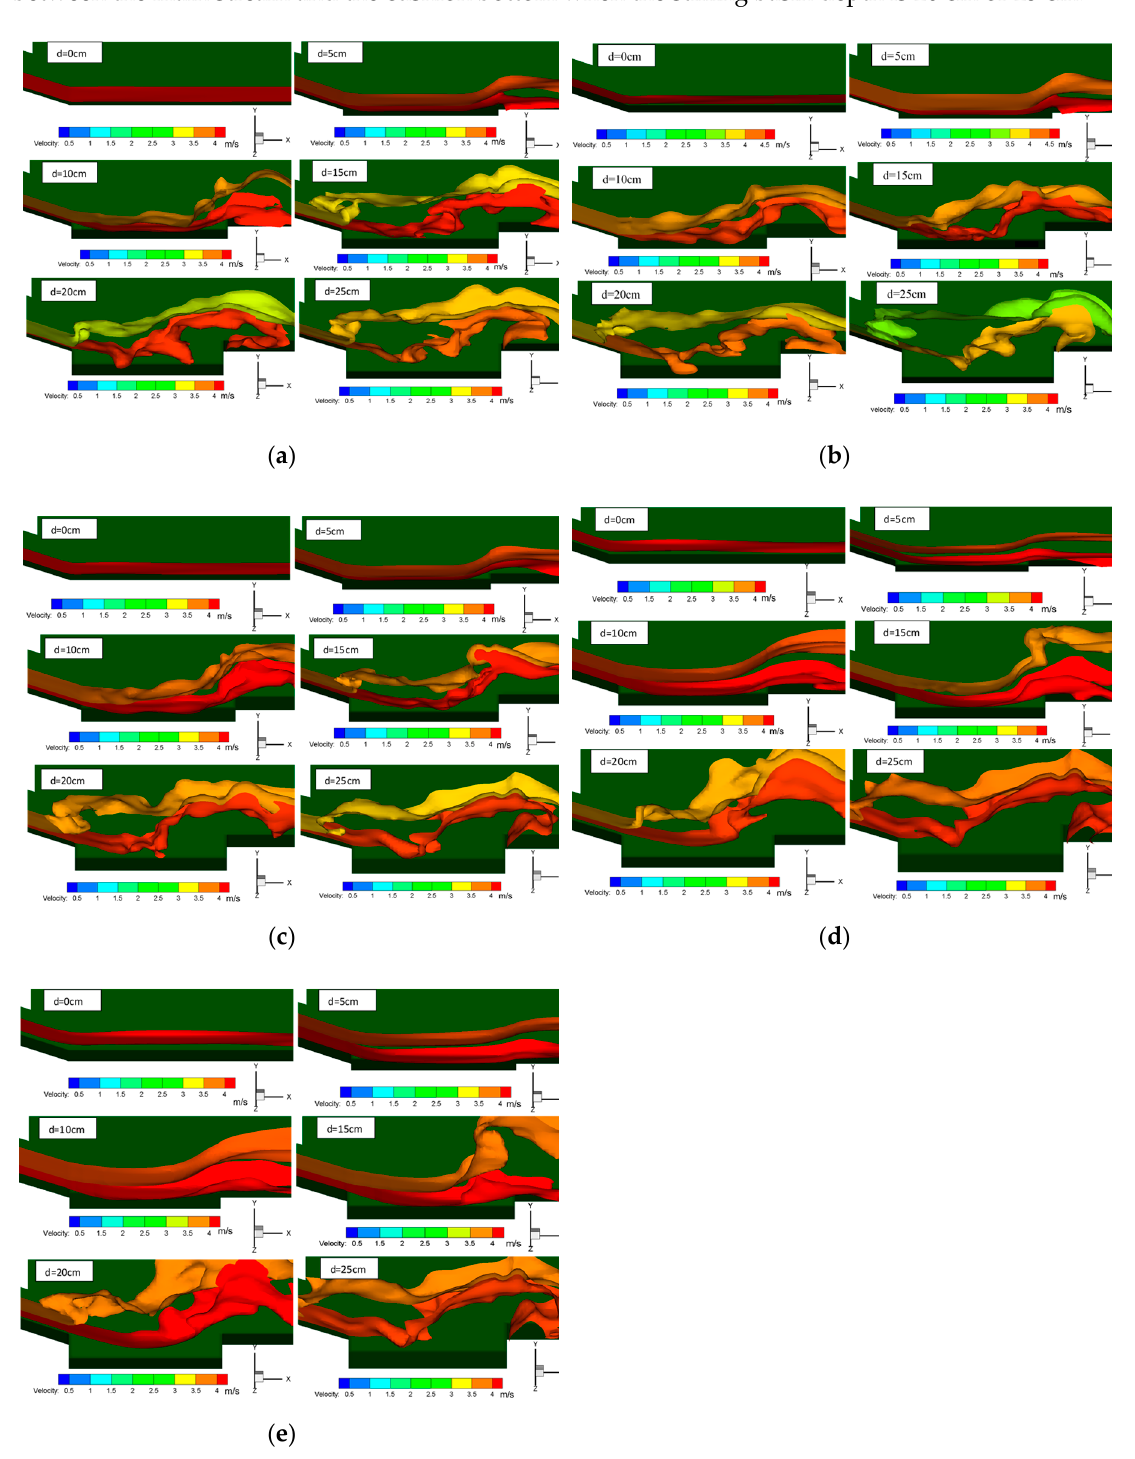
Figure 8. Main stream position in stilling basin. ( a ) Fr = 6.92; ( b ) Fr = 7.64; ( c ) Fr = 8.05; ( d ) Fr = 9.25; ( e ) Fr =